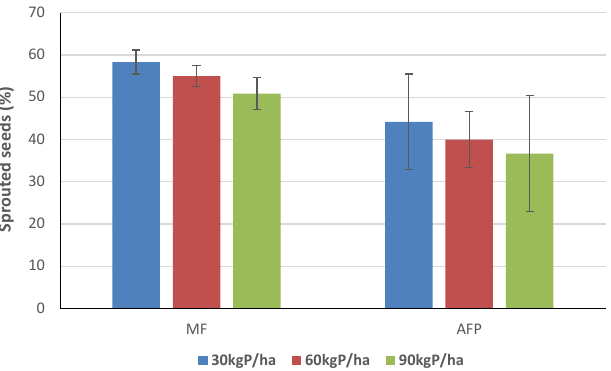
Figure 1. The number of Italian ryegrass seeds that sprouted depending on the type and amount of fertilization. MF—mineral fertilizer; AFP—hydrogel capsules with adsorbed P. Table 2. Size of leaf length and width and stem length in three successive cuts of Italian ryegrass depending on the type and amount of